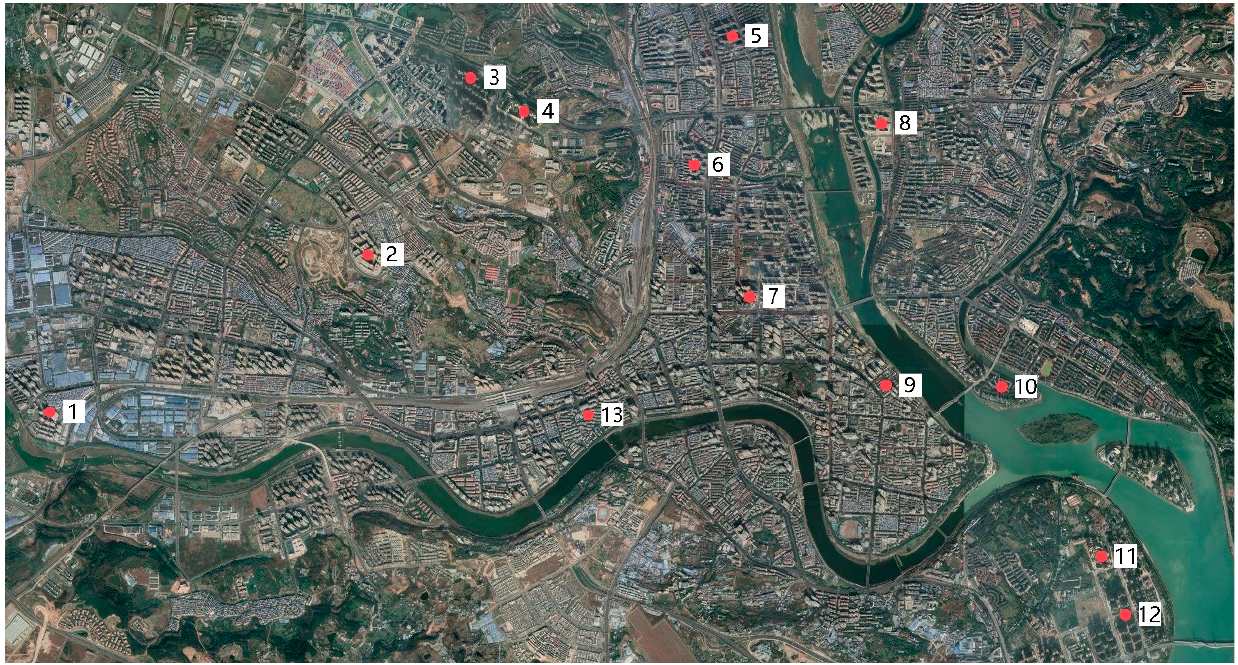
Figure 3. Distribution of surveyed communities in Mianyang. Note: The 13 dots in the figure represent the location of the selected communities in the main urban area of Mianyang.